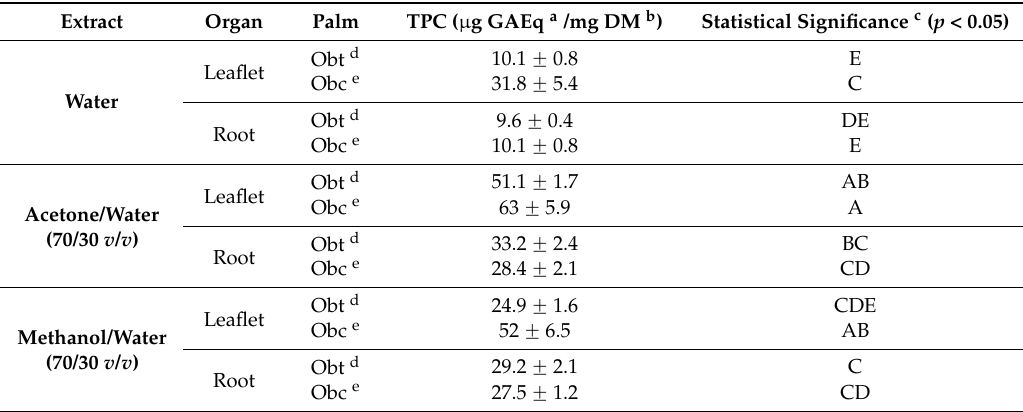
Table 1. Total Phenolic Content (TPC) of O. bataua and O. bacaba leaflet and root extracts shows total phenolic content (TPC) of Oenocarpus extracts according to extraction solvents and organs. Water extracts fromroots and leaflets had low TPC, ranging from 10 to 32 µ g GAEq /mg DM (Table 1). Extract Organ Palm TPC ( µ g GAEq a /mg DM b ) Statistical Significance c ( p < 0.05) Obt d 10.1 ˘ 0.8 E Leaflet Obc e 31.8 ˘ 5.4 Water Obt d 9.6 ˘ 0.4 Root Obc e 10.1 ˘ 0.8 Leaflet Acetone/Water (70/30 v / v ) Obt Leaflet Methanol/Water (70/30 v/v )